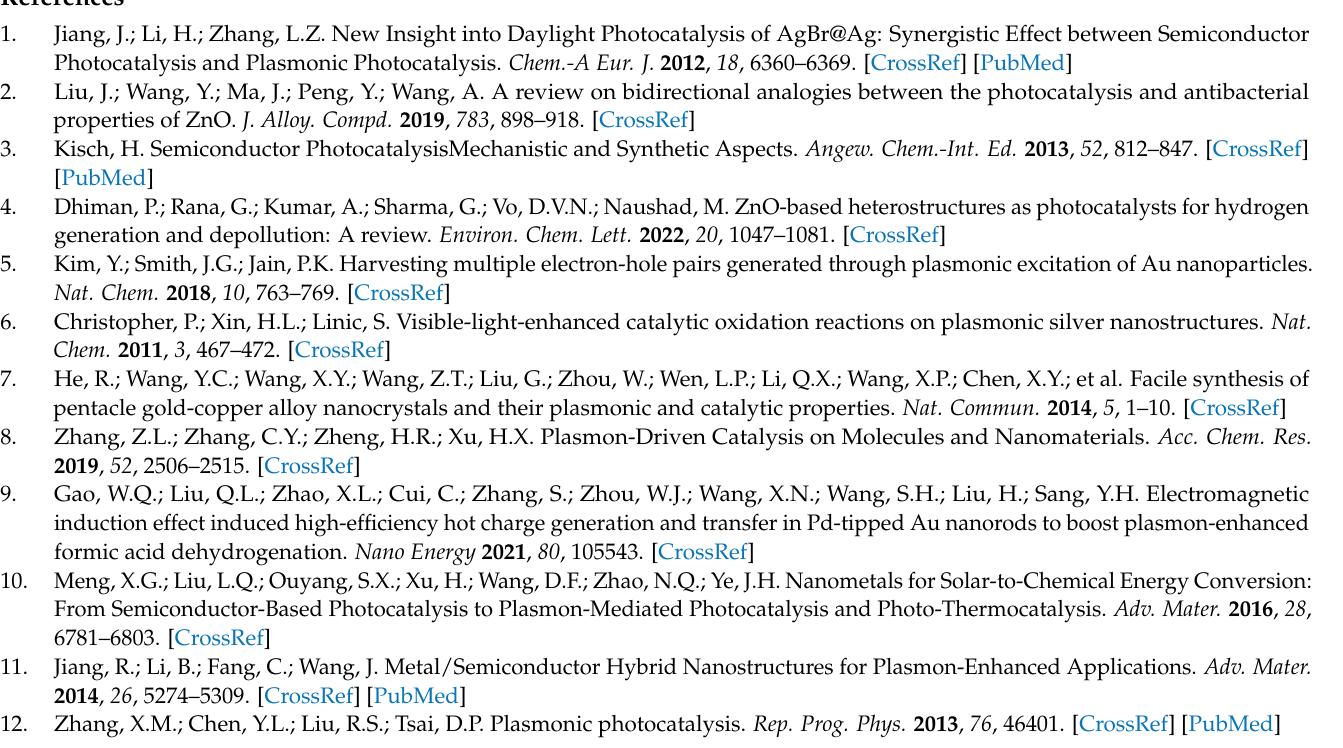
Figure S3: This is a figure. Schemes follow the same formatting. The UV-visible absorption spectra of Ag/p-ZnO with different Ag NPs loading; Figure S4: Time-dependent UV-vis spectra showing gradual reduction of 4-NP over Ag/p-ZnO collected at 1 min intervals continuously under natural light; Figure S5: Catalytic conversion of 4-NP over Ag/p-ZnO heterostructure under natural light; Figure S6: Comparative mixture catalysts collected at 1 min intervals continuously under natural light. (a) 1 mg-p-ZnO + 0.27 mg 4 nm Ag NPs, (b) 1 mg-p-ZnO + 0.27 mg 30 nm Ag NPs, (c) 1 mg-non- p-ZnO + 0.27 mg 4 nm Ag NPs, (d)1 mg-non-p-ZnO + 0.27 mg 30 nm Ag NPs; Table S1: Sample mass and concentration of reaction solution required for catalytic reaction; Table S2: The rate constants kapp (min − 1 ) and conversion rate calculated from Figures 5 and